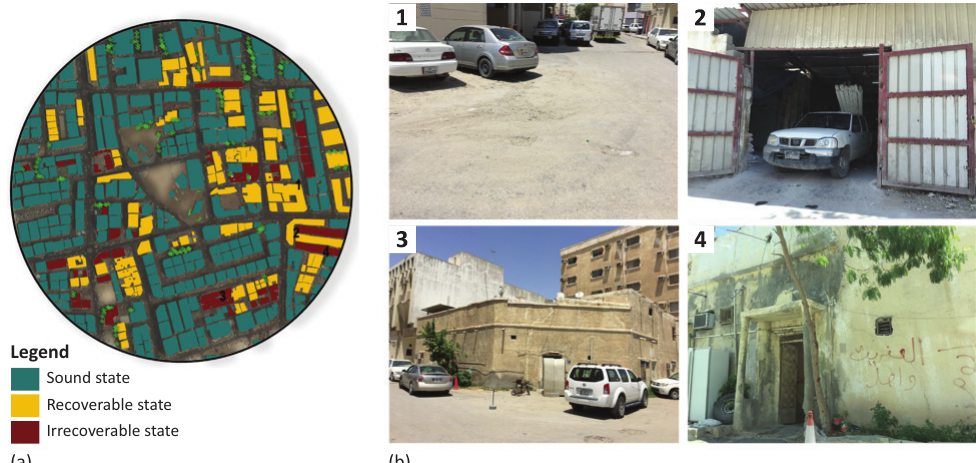
Figure 8. The surroundings within a 400 m radius: (a) Condition analysis of the area within 400 m of the metro station, and (b) photos of buildings on secondary streets which are in deteriorating